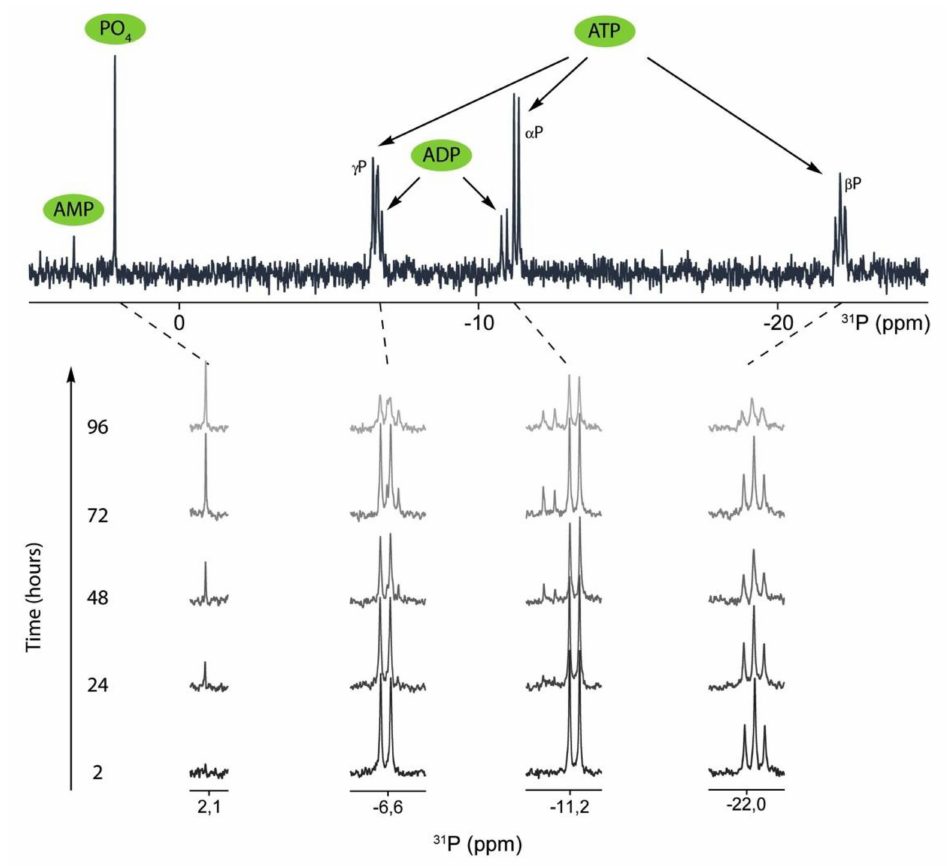
Figure 3. Hydrolysis of extracellular ATP by MOVAS cells incubated for 21 days in osteogenic medium. Thereafter, cells were washed, fixed, and incubated in Tris buffer at the indicated times of 0, 24, 48, 72, and 96 h in active medium containing 50 mM ATP. Then, 5 mM levamisole was added into the medium to inhibit TNAP. The absence of PP i (no peak at − 7.45 ppm) indicated that ATP hydrolysis by MOVAS cells was sequential and formed ADP and